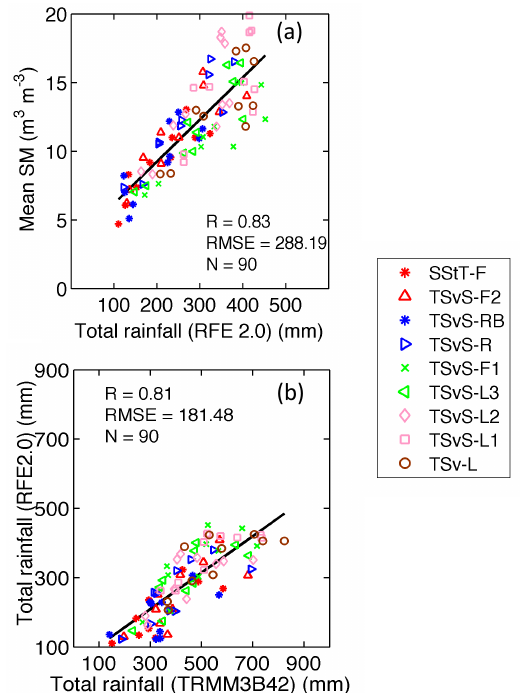
Figure 5. The total amount of rain from June through September averaged for the period 2000–2010 over the area of each vegetation-soil zone (VSZ, see Table 3 for legend items): ( a ) comparison between RFE rainfall and the soil moisture, and ( b ) comparison between TRMM and